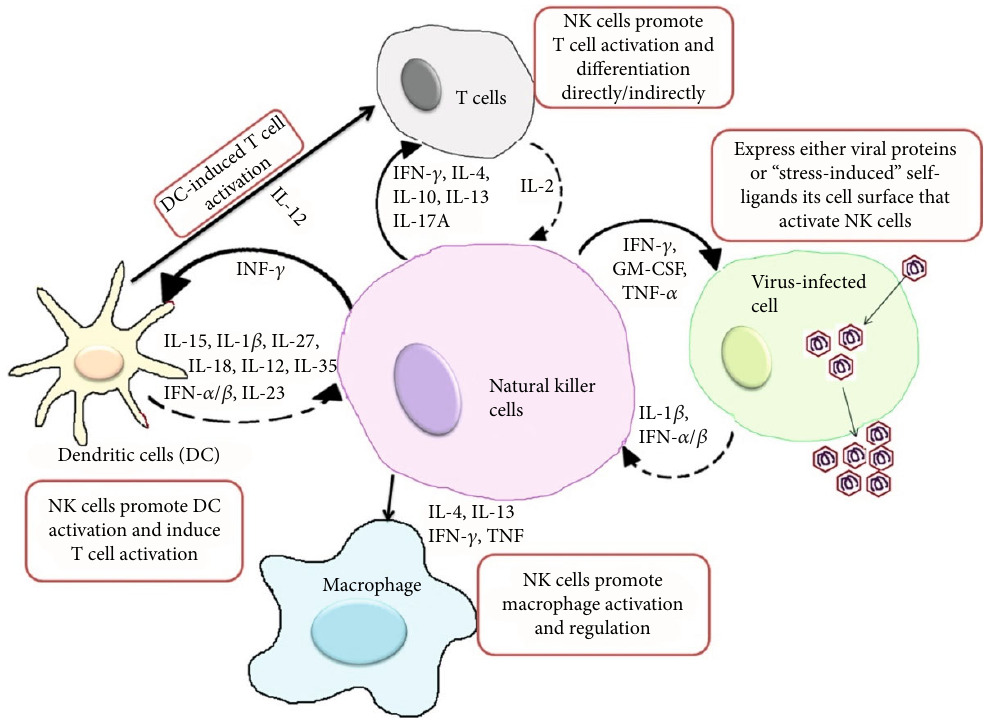
Figure 2: Natural killer (NK) cell action against viral infection. NK cells perform diverse functions such as innate immunity and produce soluble factors that have the ability to mediate killing target cells by their immunological